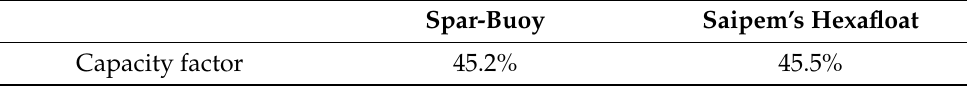
Table 6. Capacity factors of the two different platform concepts.